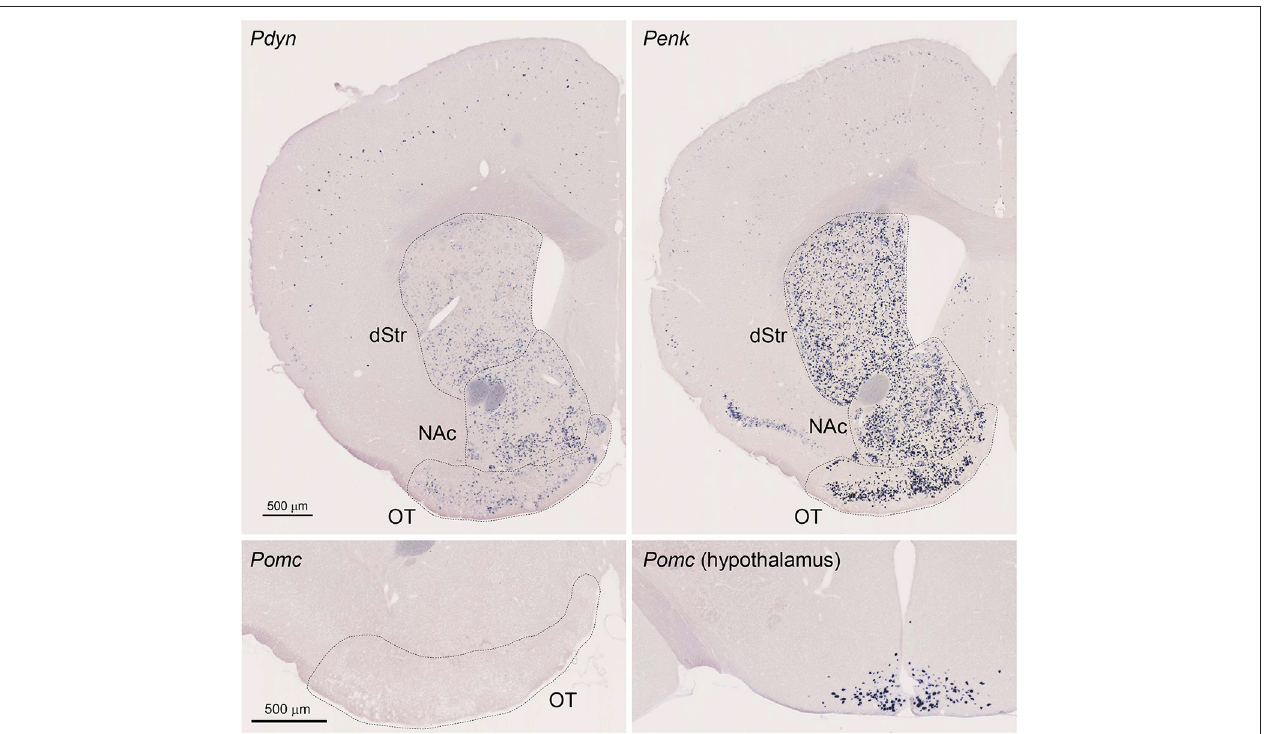
FIGURE 1 | Single Probe in situ hybridization (ISH) for Pdyn and Penk in the mouse striatum. Pictures show coronal sections of the anterior OT [approximately at Bregma + 1.70mm of Paxinos and Franklin’s the Mouse Brain in Stereotaxic Coordinates ( Franklin and Paxinos, 2008)] except for the lower right panel showing the hypothalamus (approximately at Bregma − 1.58mm). Upper left panel; Pdyn, Upper right panel Penk, Lower panels; Pomc. OT, olfactory tubercle; NAc, nucleus accumbens; dStr, dorsal